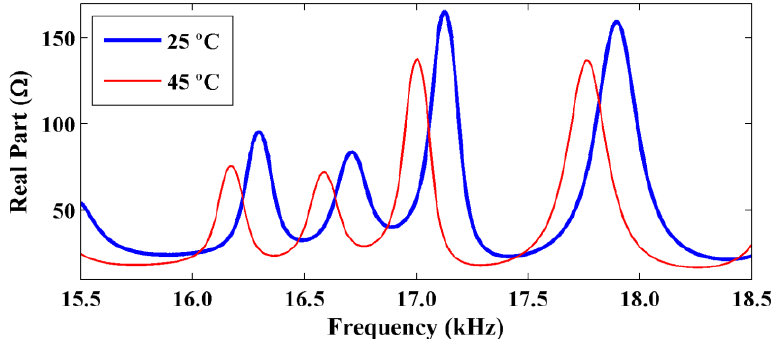
Figure 2. Variations in the amplitude and frequency shifts in real part of the electrical impedance resulting from temperature